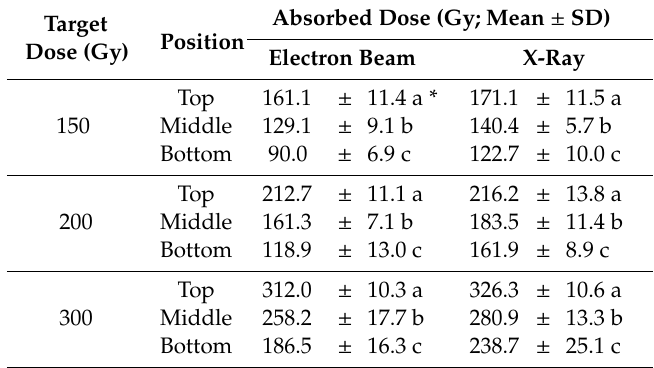
Table 3. The absorbed doses of electron beam and X-rays according to their location in boxes filled with strawberry fruits.